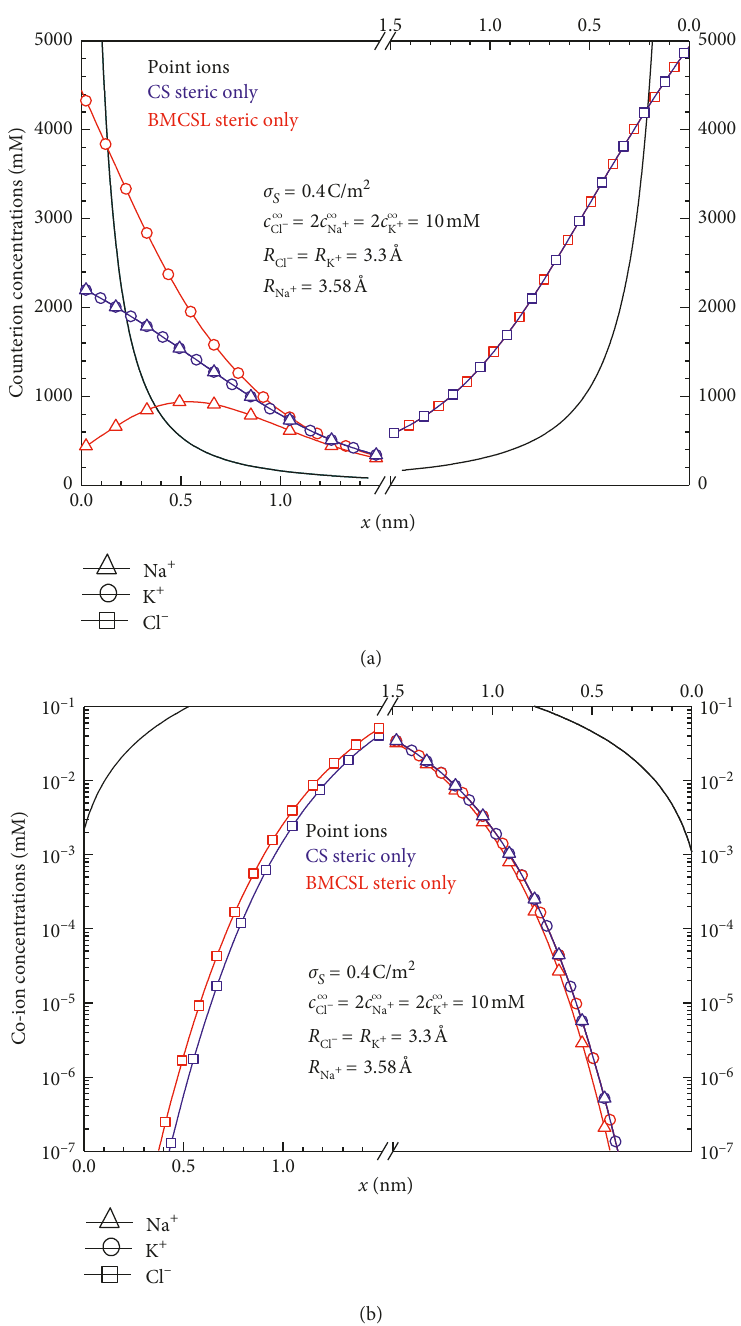
Figure 3: (a) Counterion and (b) co-ion concentration profiles in the diffuse electric double layers near negative (left) and positive (right) interfaces, calculated using the CS and BMCSL steric interaction only models and mixed aqueous NaCl and KCl solutions with the indicated